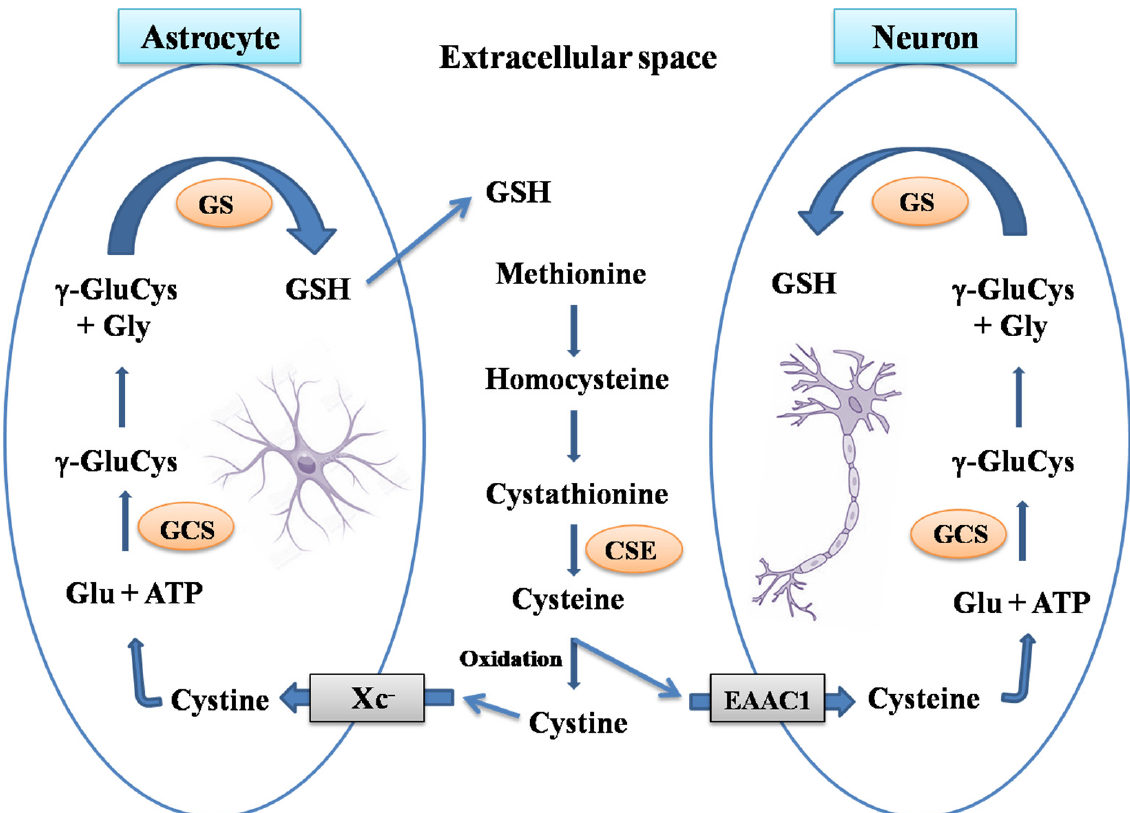
Figure 2. GSH synthesis in astrocytes and neurons. The Transsulfuration pathway synthesizes homocysteine from the dietary amino acid methionine to produce cystathionine. Further, cystathionine- γ -lyase (CSE) converts cystathionine into cysteine in extracellular to neurons and astrocytes. Neurons utilize extracellular cysteine for GSH synthesis, unlike astrocytes which uses the oxidized form cystine. Neurons uses excitatory amino acid transporter (EAATs) to take up cysteine, while a cystine/glutamate transporter (Xc-) mediates the transport of cystine in astrocytes. γ -Glutamylcysteine synthetase (GCS), rate limiting enzyme in GSH synthesis catalyzes the formation of γ -glutamylcysteine dipeptide utilizing ATP. γ -GluCys is then combined with glycine to form GSH by glutathione synthetase (GS) in both neurons and astrocytes. GSH formed in astrocytes is released into extracellular space where it is cleaved into individual aminoacids by a set of enzymes. Replenishing GSH in the brain could be a promising treatment strategy for neurodegen- erative disorders. GSH does not cross blood-brain-barrier and its systemic administration is not effective to increase the concentration in the brain as most of the GSH are metabo- lized in blood. Several studies have investigated the effect of GSH precursors in a mouse model in restoring GSH. Treatment with GSH precursors has been shown to protect from A β induced neurotoxicity [36] and cognitive impairment in AD mouse models. N-acetyl- cysteine, a membrane-permeable cysteine precursor with a potent antioxidant activity